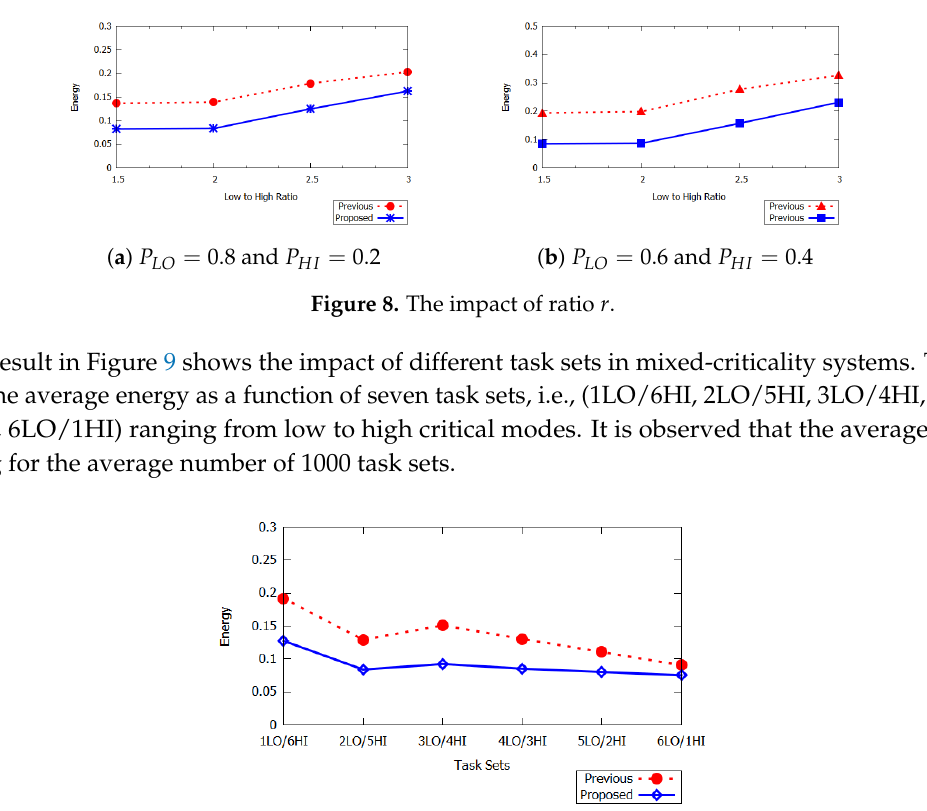
Figure 9. Impact of the number of low- and high-criticality tasks ( P HI = 0.2).